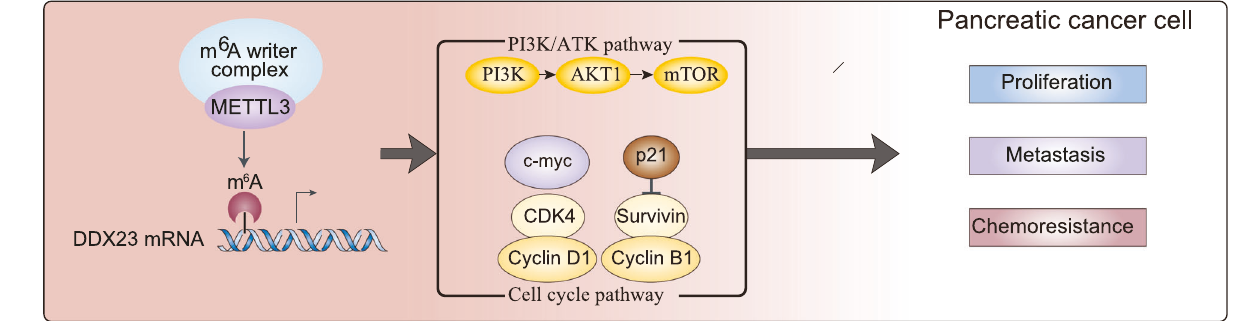
Fig. 8 A scheme illustrating the potential mechanism of how METTL3 regulates pancreatic cancer progression by regulating PI3K/Akt signaling and cell cycle progression via m6A modifying DDX23